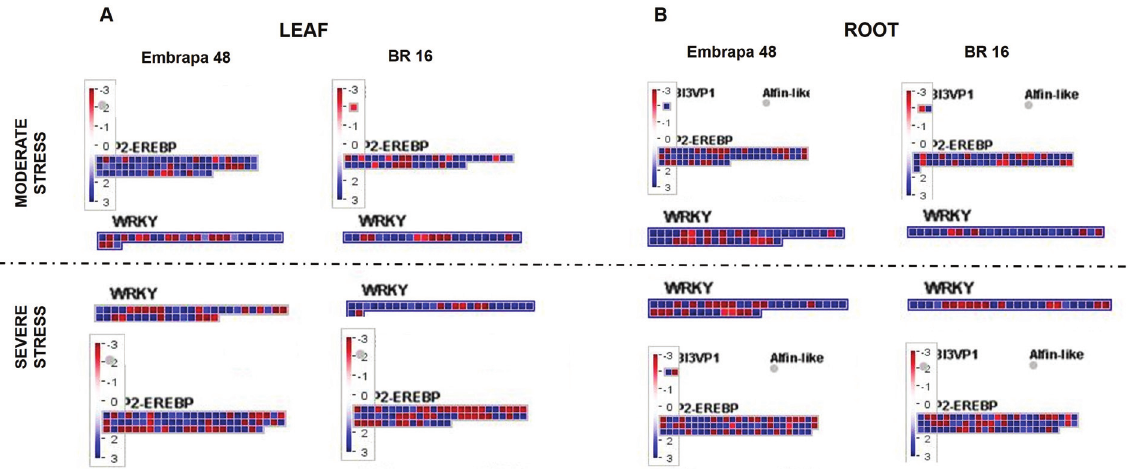
Figure 11 - Modified maps of MapMan 3.6 ORC. Genes differentially expressed in response to water deficit were mapped to specific stress-related TF families AP2/EREBP and WRKY for (A) leaf from Embrapa 48 and BR 16 and (B) root from Embrapa 48 and BR 16 under moderate and severe stress. The color scale shows the log2 fold-change: red = down-regulated and blue =